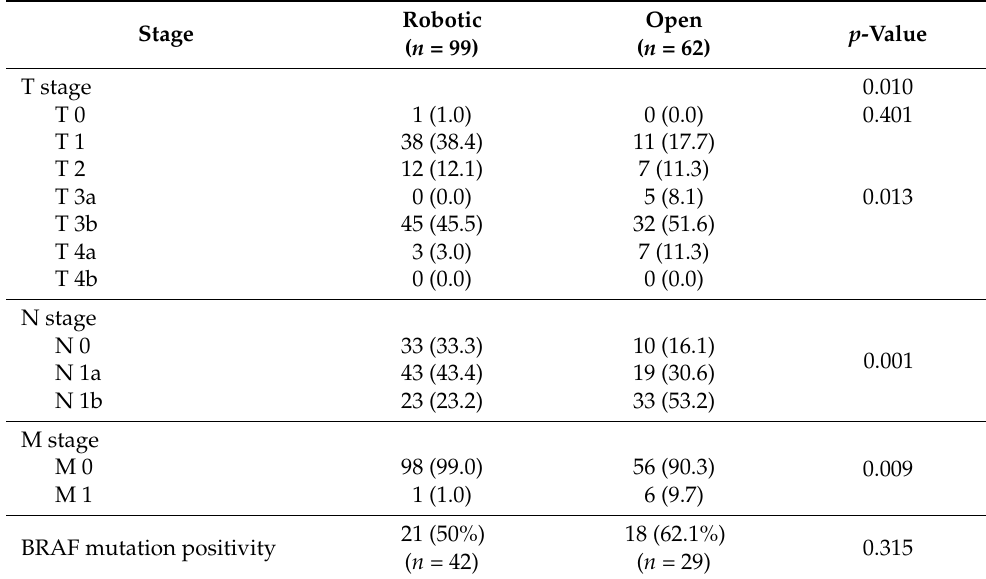
Table 4. Comparison of TNM stage and BRAF mutation between patients treated with robotic and open thyroidectomy.